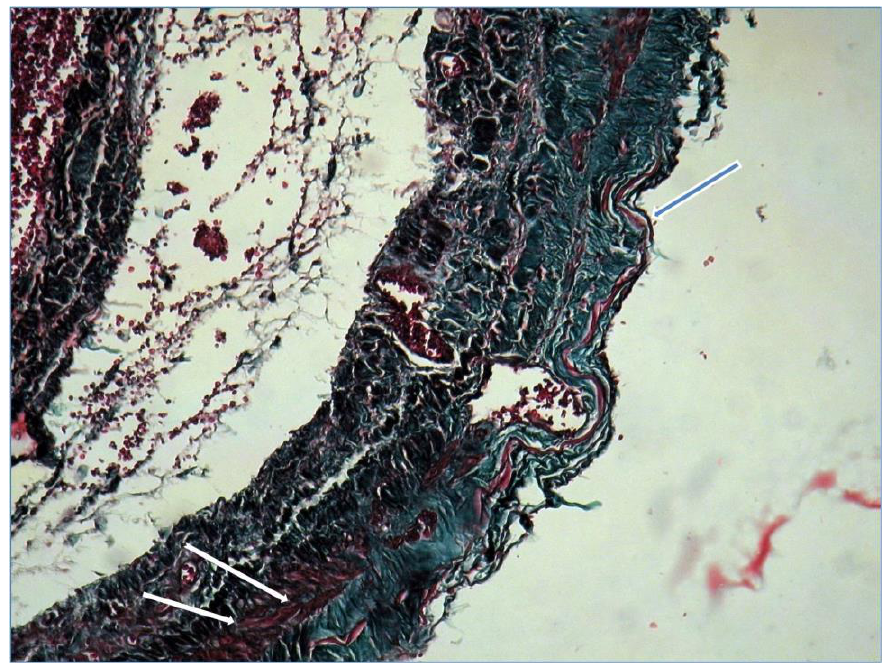
Figure 5. Microscopy confirming the diagnosis of popliteal venous aneurysm.